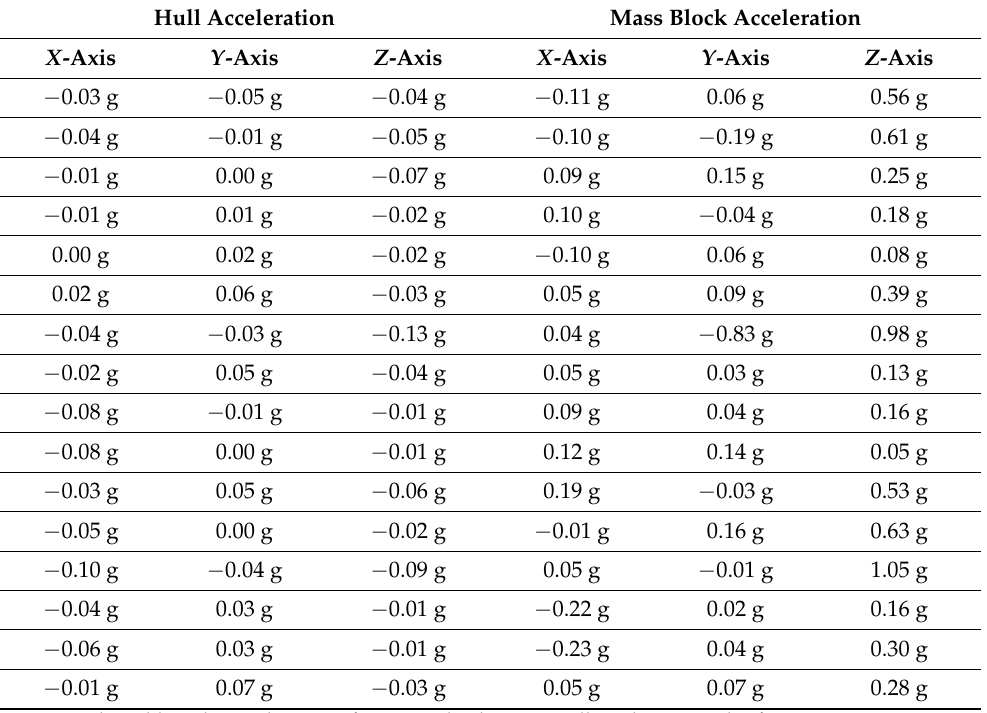
X -axis, Y -axis and Z -Axis. They were measured by the acceleration sensor after the mass